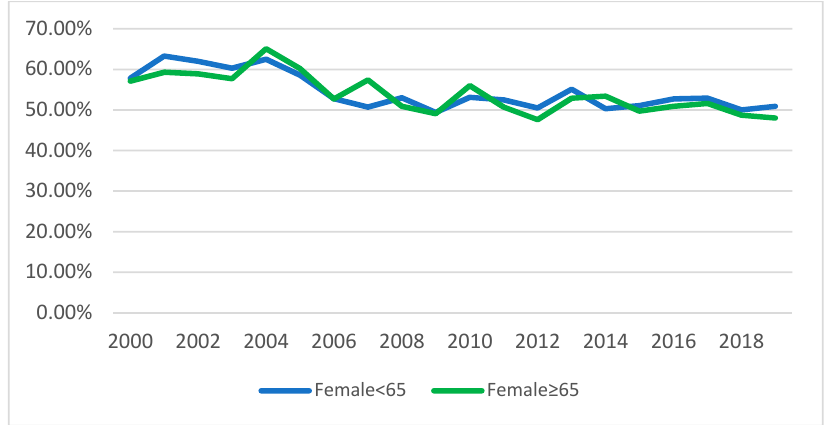
Figure 3. Percentage of consultations, per year, made to female patients.